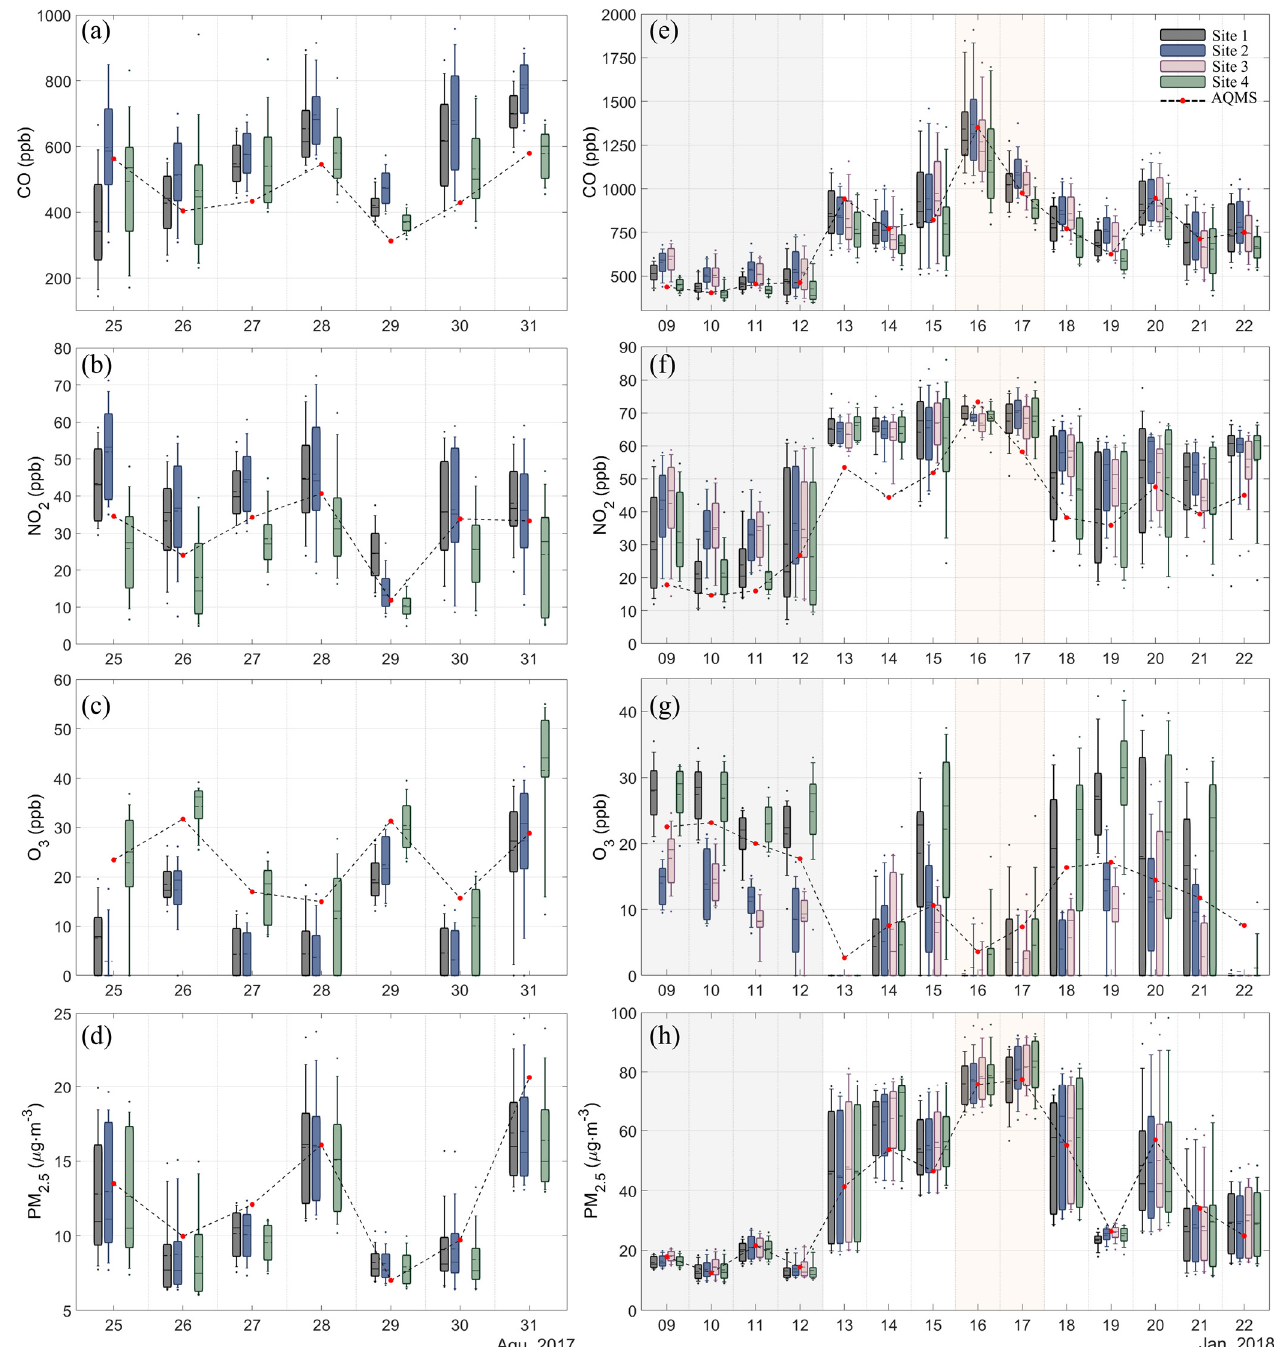
Figure 5. Box plots of the daily variations in air pollutants at each sub-site (dark gray: Site − 1, dark blue: Site − 2, pink: Site − 3, and green: Site − 4). The horizontal dashed lines in the box denote the mean values. Dotted lines with red dots represent the daily mean concentrations from the AQMS. The left panel ( a – d ) shows the daily variations for the summer period, and the right panel ( e – h ) shows those for the winter. The gray shaded area in winter represents the cold wave period, and the red shaded area represents the high PM 2.5 event. Ozone data were used only for the period 11:00–17:00 because of the near-zero concentrations during the